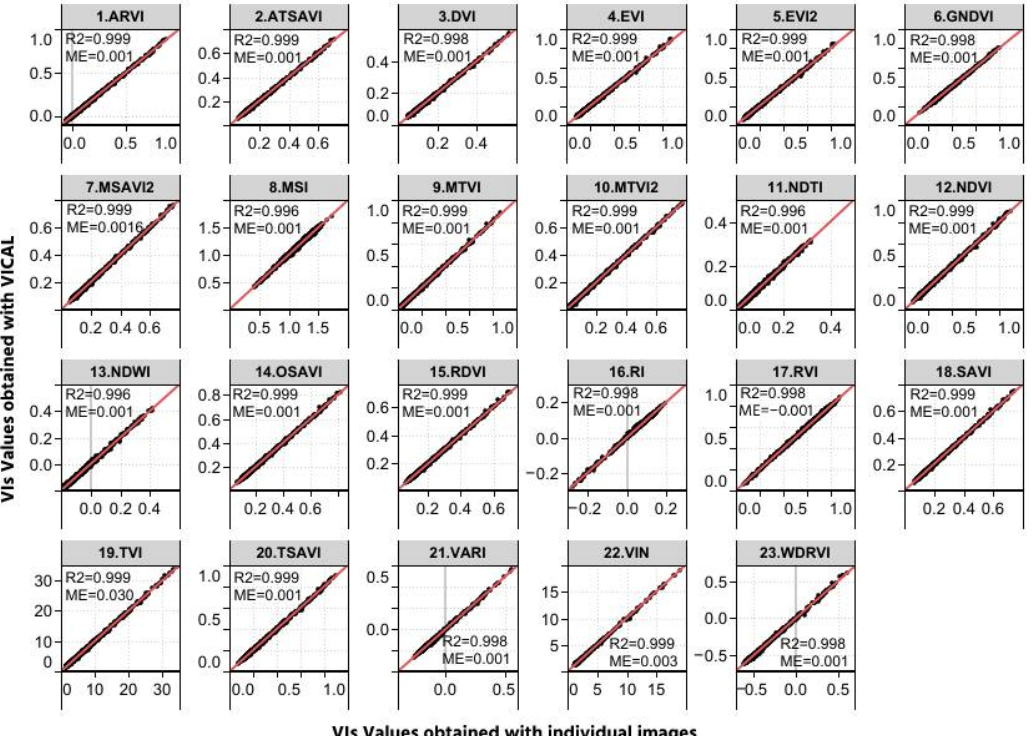
Figure 9. R 2 and ME values of the VIs obtained by VICAL and those obtained through the individual processing of Sentinel-2